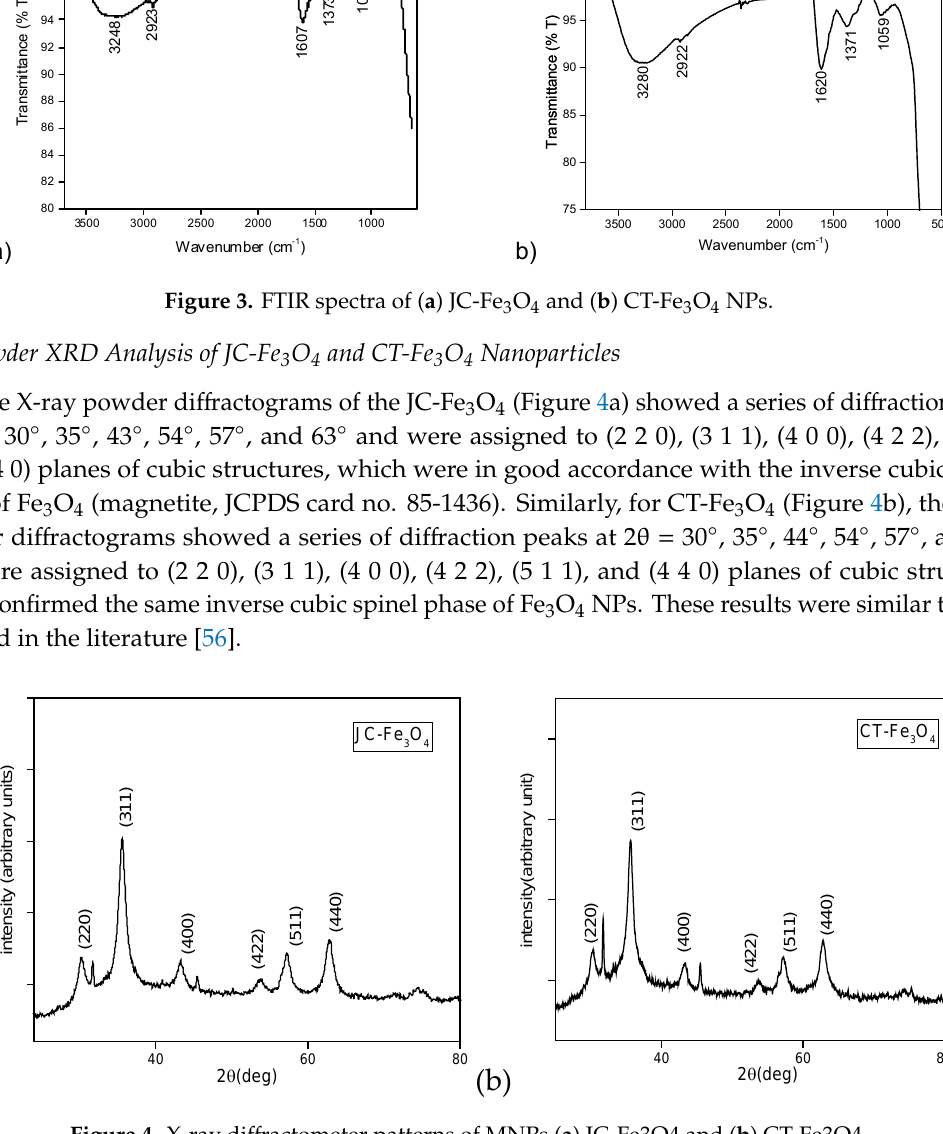
Figure 4. X-ray diffractometer patterns of MNPs ( a ) JC-Fe3O4 and ( b ) CT-Fe3O4.